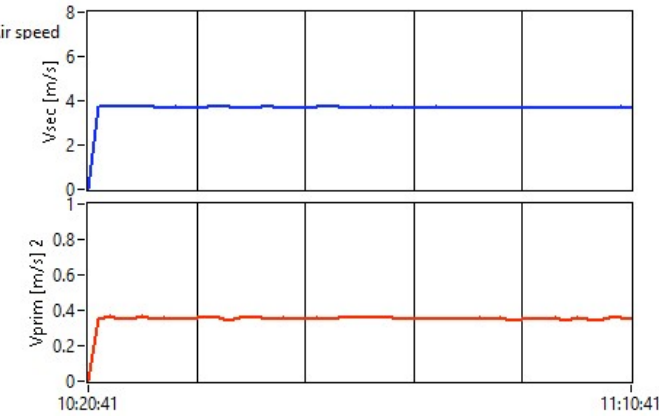
Figure 11. Evolution of primary and secondary air speed with a ratio of 1/3 and a flow rate of 25/50 L/min, during the test.